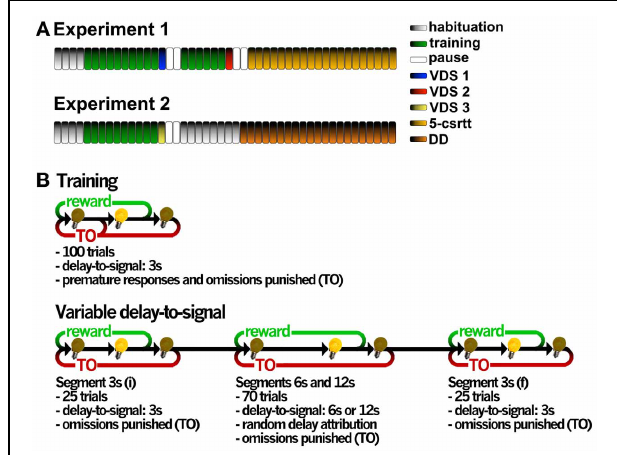
FIGURE 1 | General organization of the validation experiments and operational diagrams of the VDS and preceding training protocol. (A) In experiment 1, two VDS protocols were performed in the same group of animals to test for methamphetamine and MK-801 effects on impulsivity, followed by the 5-csrtt performed in drug-free conditions during the whole protocol. In experiment 2, VDS was followed by DD. Each bar represents a session, except for 5-csrtt and DD whose protocol extension varied between individuals. (B) The VDS consisted in two parts: the training protocol (10 sessions) and the VDS proper (1 session); while in the first the delay-to-signal was fixed (3s) and pre-signal nose pokes were